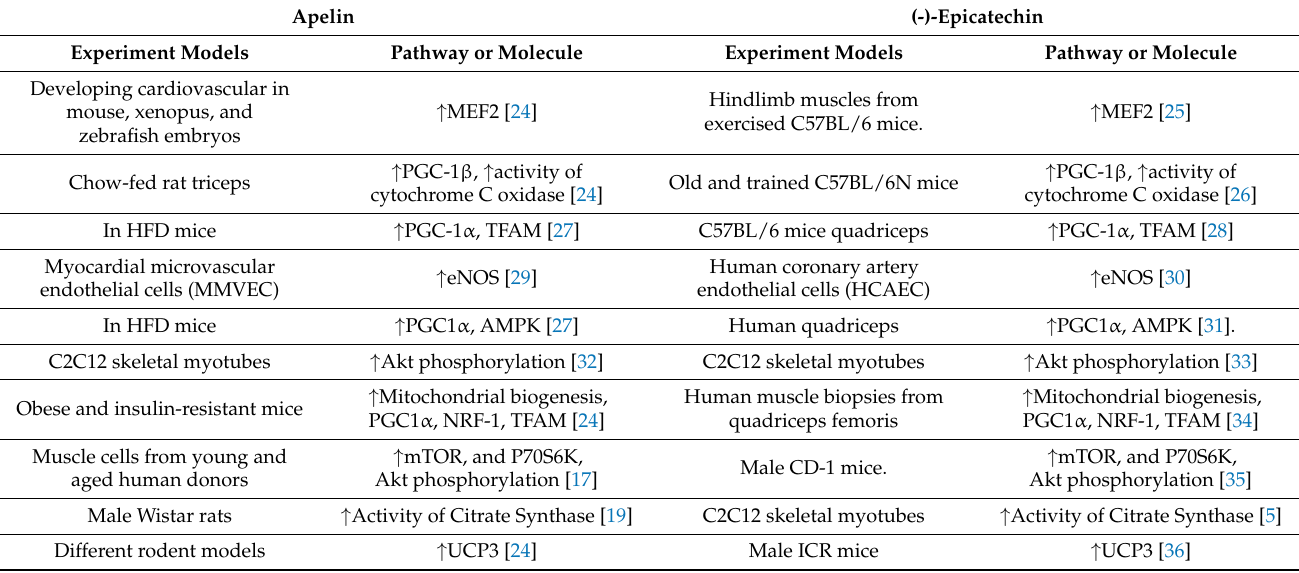
Table 2. Comparative effects of APJR stimuli and reported (-)-epicatechin-induced effects on skeletal muscle. ↑ = increased values. Apelin (-)-Epicatechin